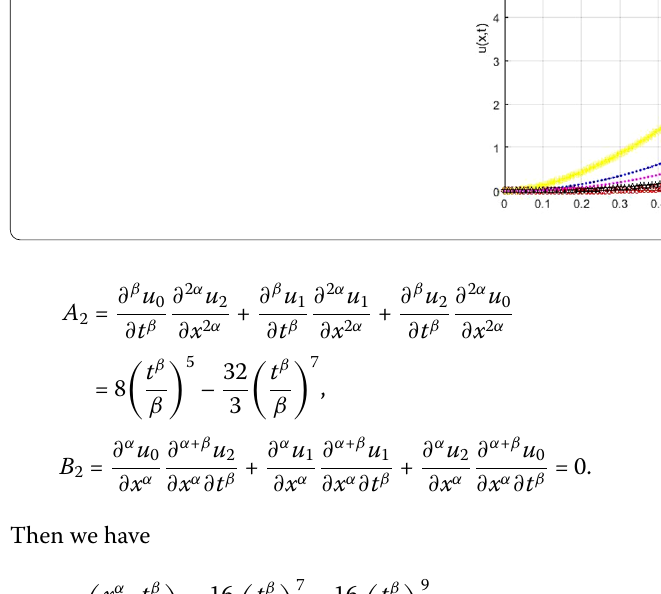
Figure 2 The exact and approximate solutions of u(x,t), for Example 5, we take different values of fractional orders of α and β : α = 0.55, β = 0.88, α = 0.44, β = 0.80, α = 0.93, β = 0.75, and α = 0.74, β =